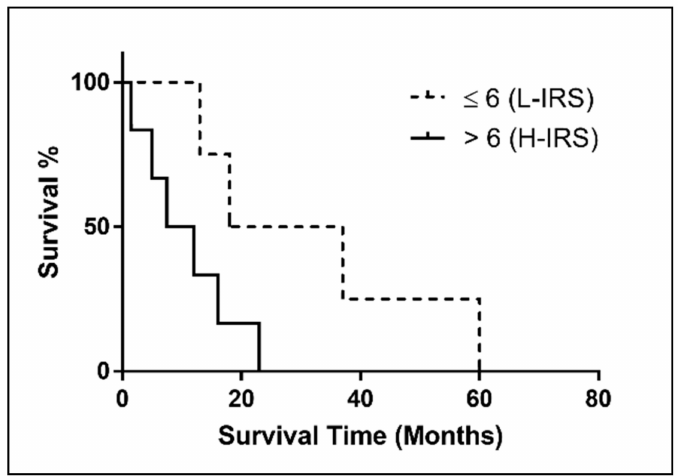
Figure 3. Kaplan–Meier survival curve of SRSF1 expression (IRS) in FE-induced MM patients. ( p = 0.0563).